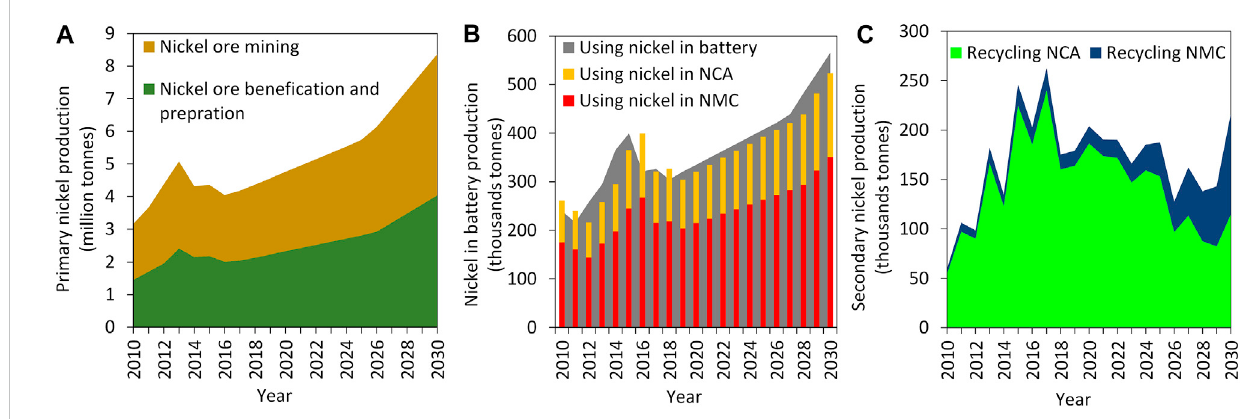
FIGURE 2 Global mass fl ows of nickel between 2010 and 2030. (A) Mining stage, (B) production stage, (C) Recycling